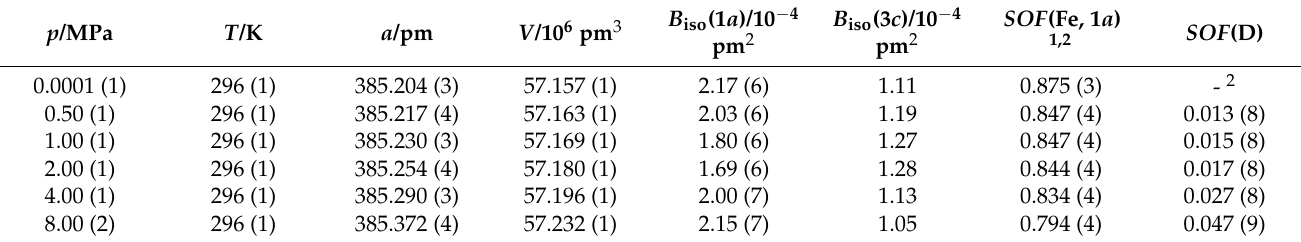
Table A6. Conditions and refined parameters of the Rietveld refinement of FePd 3 ( Pm 3 m ) based on in situ NPD data (see Figures 2–4 and A9–A14, and Table A7) using FullProf [24].